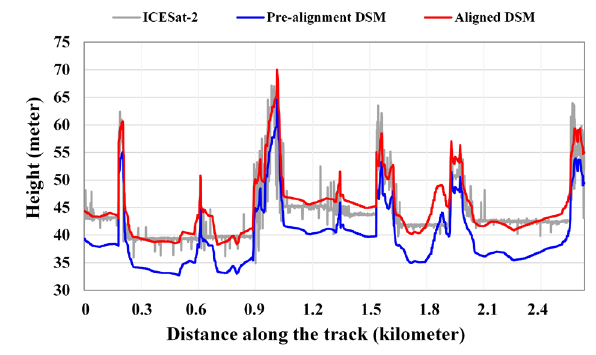
Figure 5. Height profile of DSM before and after